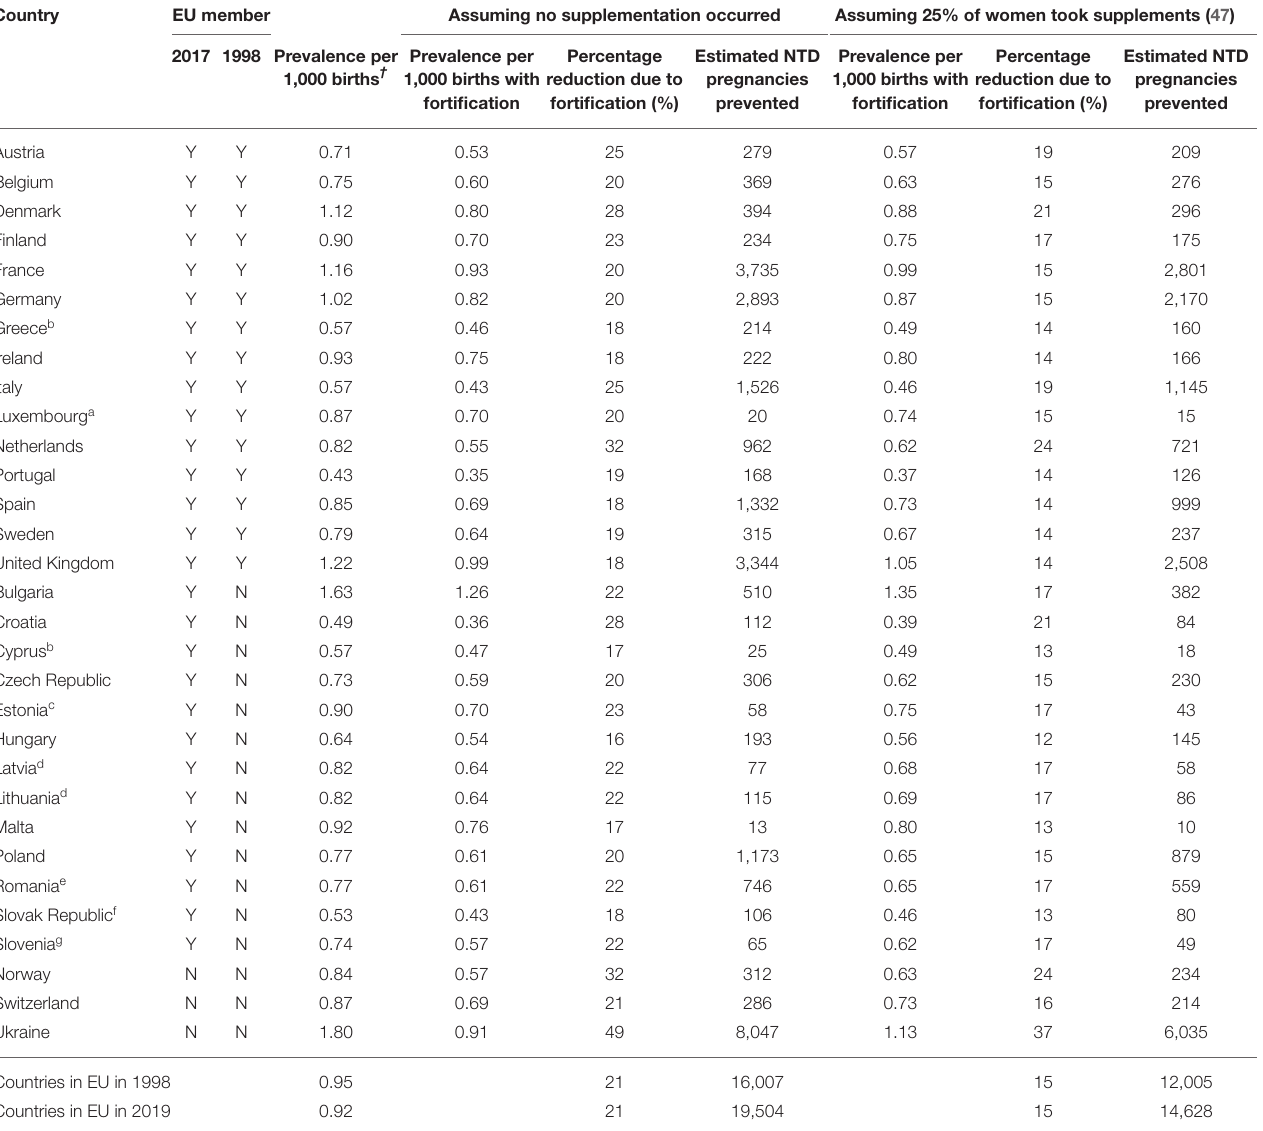
TABLE 3 | NTD: numbers of pregnancies and the prevalence if fortification had occurred from 1998 to 2017 according to European country. Country EU member Assuming no supplementation occurred Assuming 25% of women took supplements